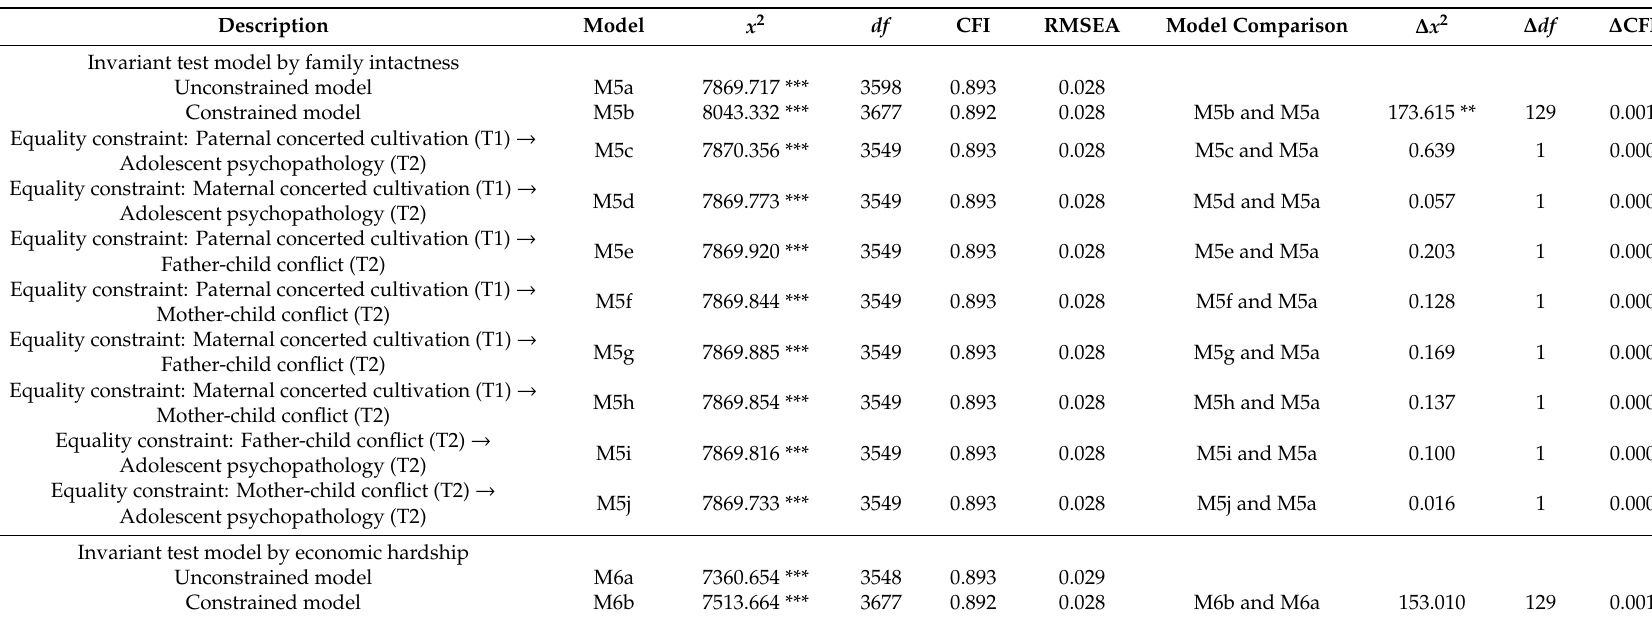
Table 5. Goodness-of-fit indicators of the measurement model, structural model and invariant test model by adolescent gender, family intactness and family economic hardship